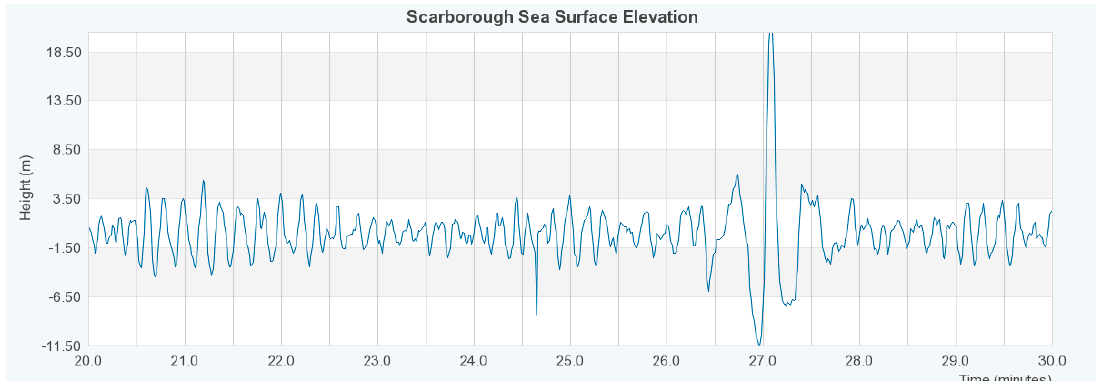
Figure 2. Ten-minute trace of 1.28 Hz data from the Scarborough wave buoy recorded on 13 January 2017 between 13:20 and 13:30UT. The spike between minutes 24 and 25 is the moment of shock to the accelerometers, leading to the apparent long and high wave artefact approximately 2 min after the initial shock.